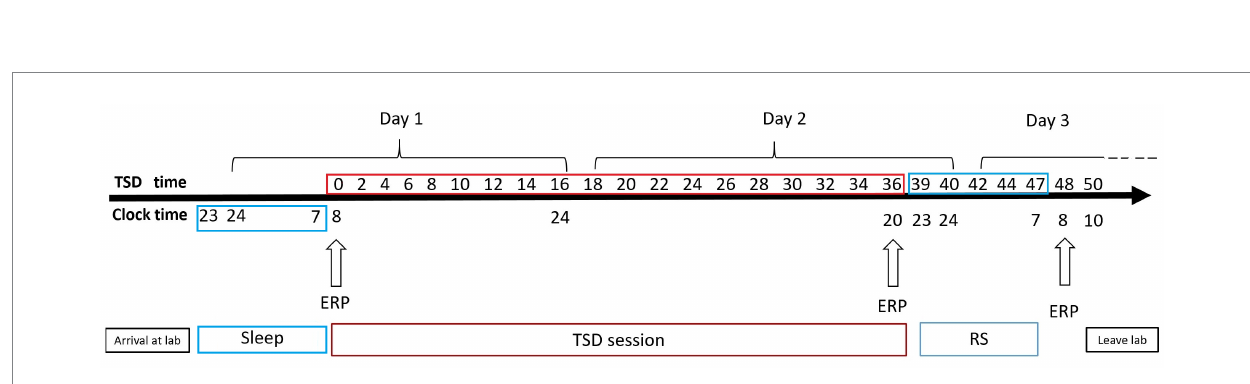
FIGURE 3 Experimental design for the sleep deprivation (SD) group. After 8 h of sleep in our laboratory, participants underwent 36 h of total sleep deprivation (TSD), followed by 8 h of recovery sleep (RS). Electroencephalographic data were recorded simultaneously. The arrows indicate various time points during the 2-back working memory